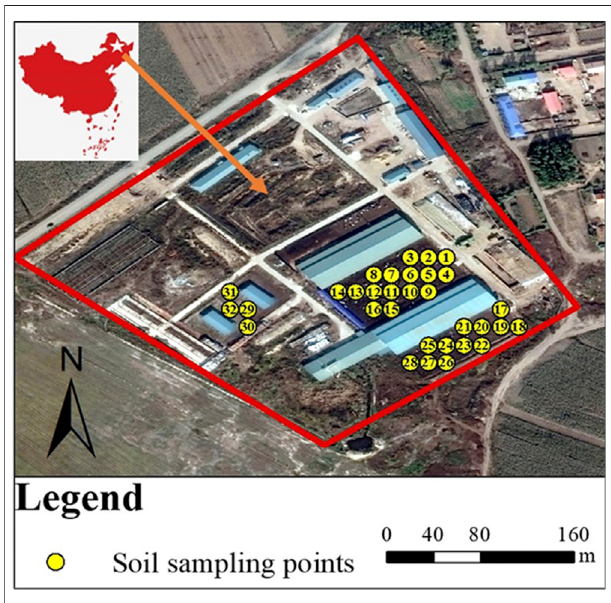
FIGURE 1 | The GIS image showing the exact location and sampling points of the dairy farm in